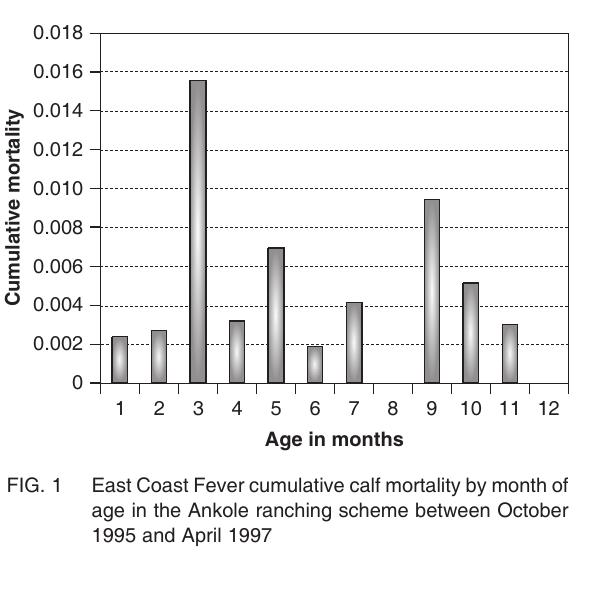
FIG. 2 Mean T. parva antibody titres (percent positive values with standard error of the mean) of the Ankole calves in the Ankole ranching scheme between October 1995 and April 1997. The line is a polynomial trend line for mean predicted percent positive